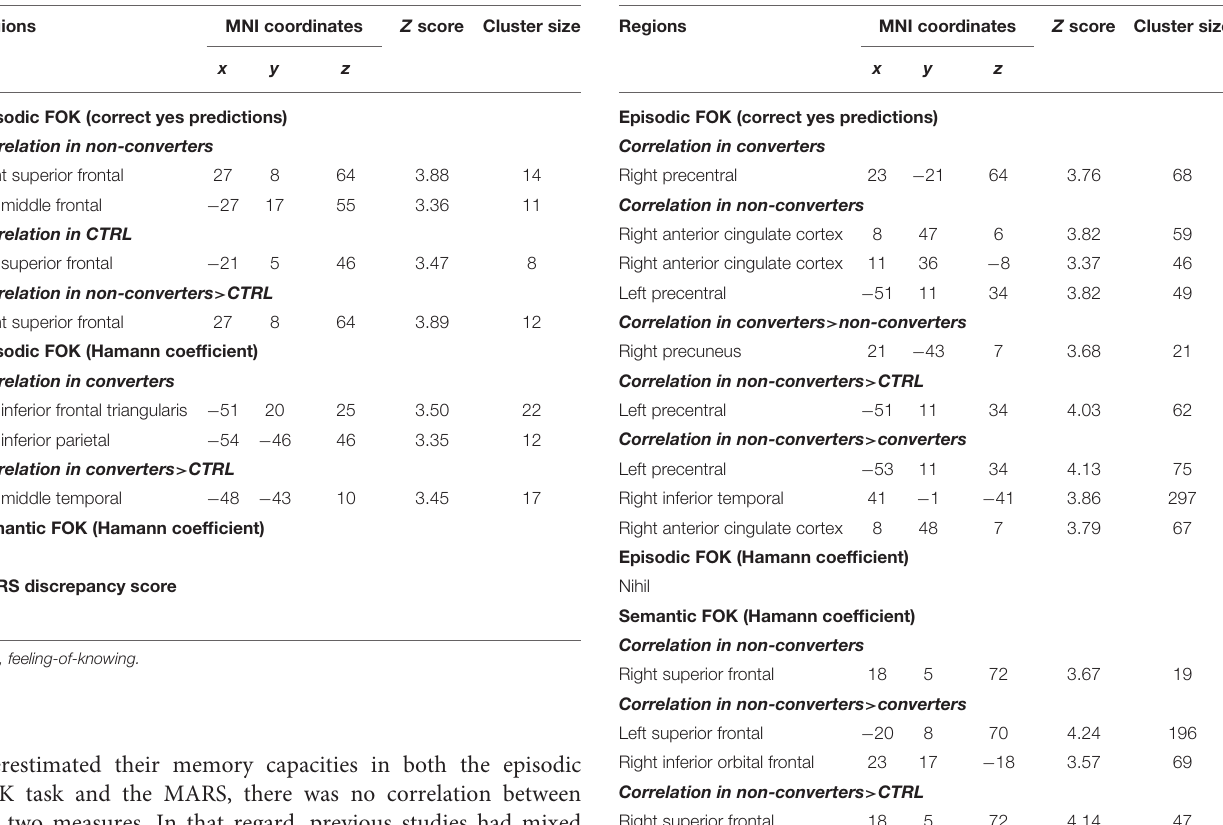
TABLE 5 | SPM results: Significant correlations between regional gray matter density and self-awareness measures (small volume correction, p < 0.05 FWE-corrected for multiple